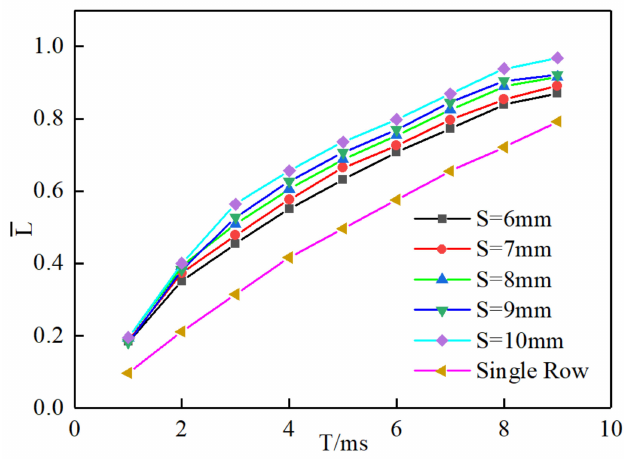
Figure 18. Evolution of length.